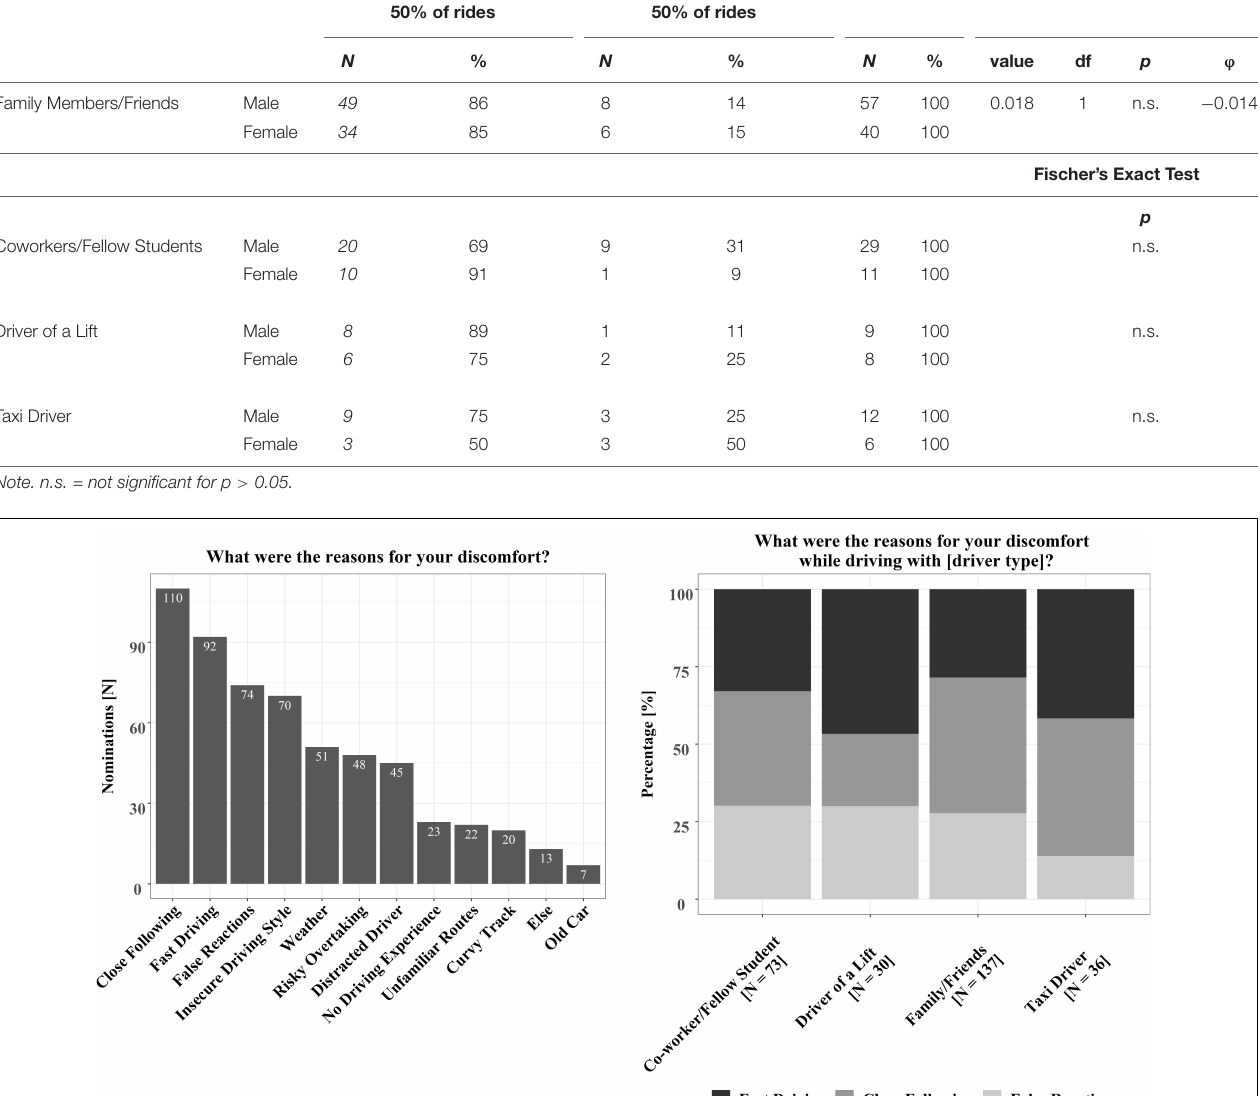
TABLE 1 | Distribution of uncomfortable rides for female and male participants per driver group. Driver Group Sex Discomfort in less than